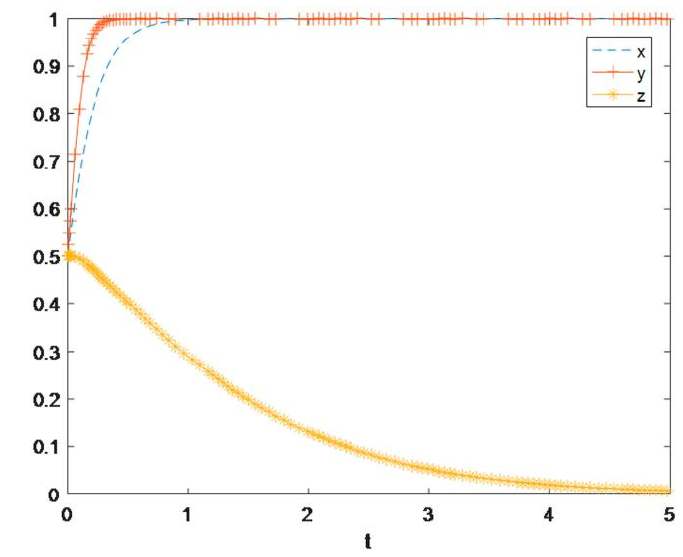
Figure 9. Two-dimensional diagram of evolutionary path at stable point (1, 1, 0).